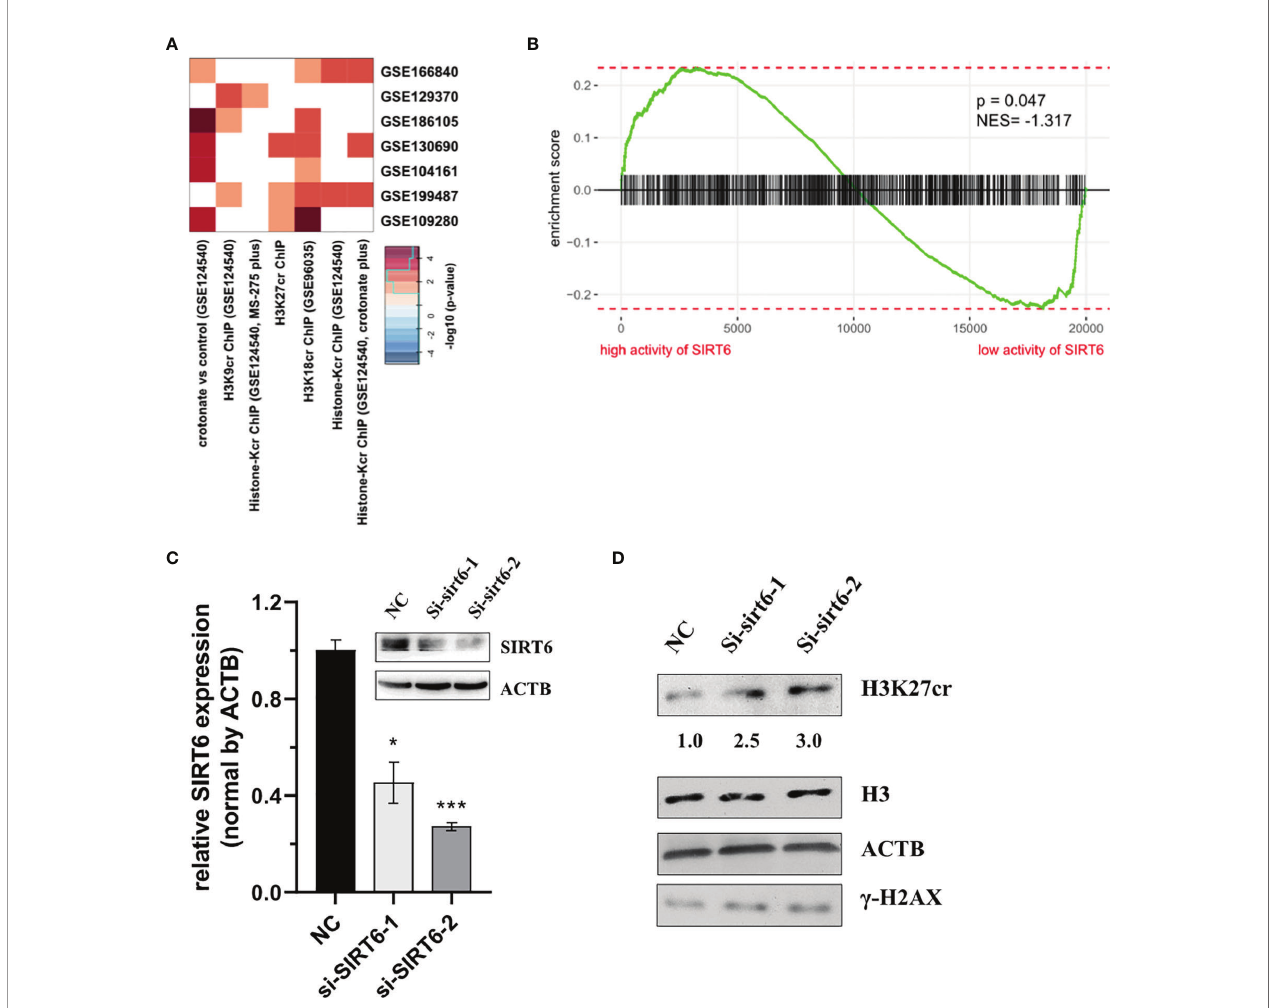
FIGURE 5 | SIRT6 regulates the cellular level of H3K27cr. (A) Heat map showing that the genes with promoter occupied by histone crotonylation were involved in multiple gene sets regulated by SIRT6 in Fisher ’ s exact test. The color intensity indicates the negative base 10 logarithm of the p -value. The white spaces meant that P > 0.05. (B) Gene Set Enrichment Analysis enrichment score curve showing that genes with promoter occupied by histone crotonylation (GSE124540) were enriched in colon cancer patients with a low activity of SIRT6. The green curve indicates the enrichment score. The negative enrichment score in the low activity end of SIRT6 means the upregulation of histone crotonylation pathway in the COAD samples with a low activity of SIRT6. (C) Western blot and qRT-PCR analysis of the level of SIRT6 in HCT- 116 cells transiently transfected with siSIRT6 for 48 h. The level of mRNA expression was normalized to that of ACTB. Data are presented as means ± SD; * P < 0.05, *** P < 0.001; unpaired, two-tailed, Student ’ s t -test. (D) Immunoblotting analysis of H3K27cr level in HCT-116 cells transiently transfected with siSRIT6 for 48 h. The ACTB acts as protein loading control. The numbers under the H3K27cr panel represent the ratio of the level of H3K27cr versus H3 in the treatment group to that in the control group as analyzed by Image J2 software. NC, negative control (randomized siRNA